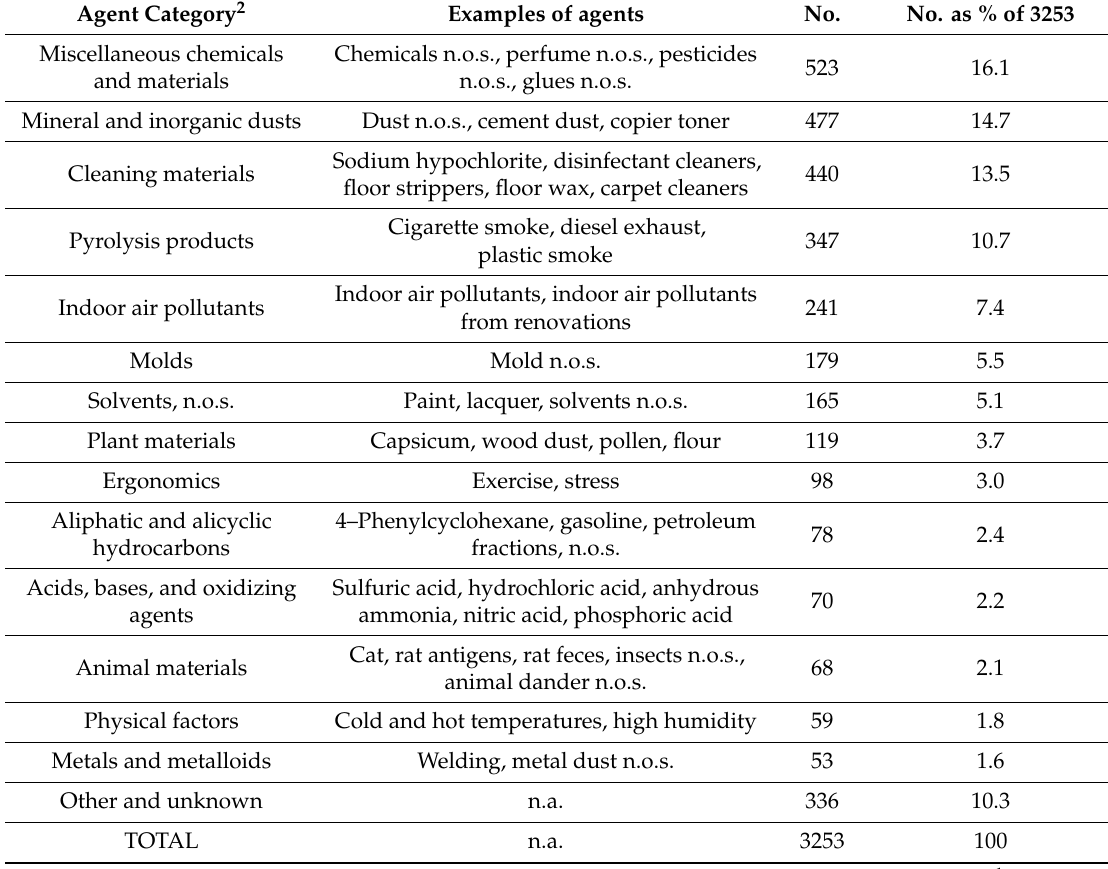
Table 1. Distribution of 3253 putative agents by category reported for 2209 WEA cases identified by state-based surveillance programs in the United States, 1993–2006 and 2009–2012